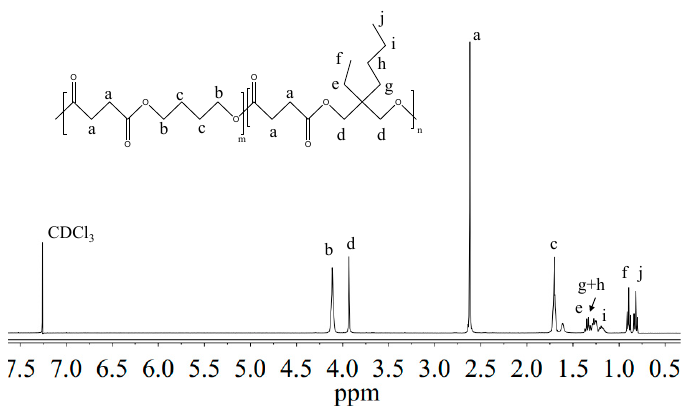
Figure 2. 1 H–NMR spectrum of P(BS 70 BEPS 30 ) with resonance assignments. Figure 2. 1 H-NMR spectrum of P(BS 70 BEPS 30 ) with resonance